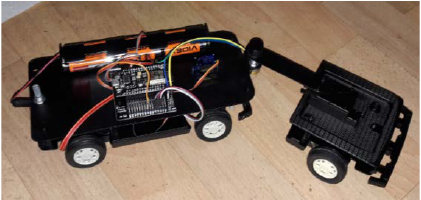
Fig. 1. Robotic installation for studying road train motion The control information for the robotic installation is gen- erated by a developed software program in C#, consisting of